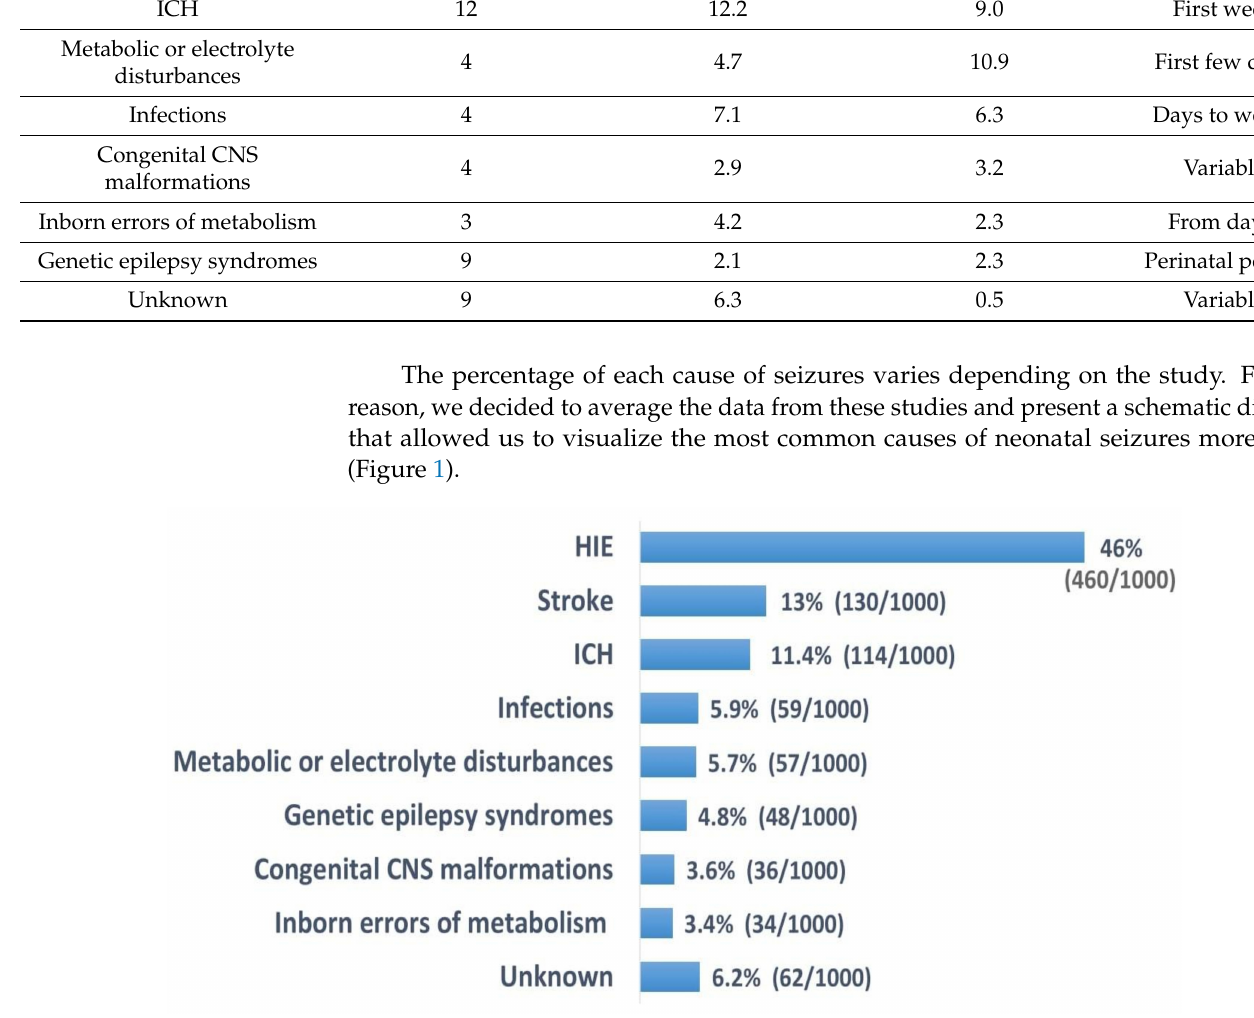
Figure 1. Most common causes of neonatal seizures